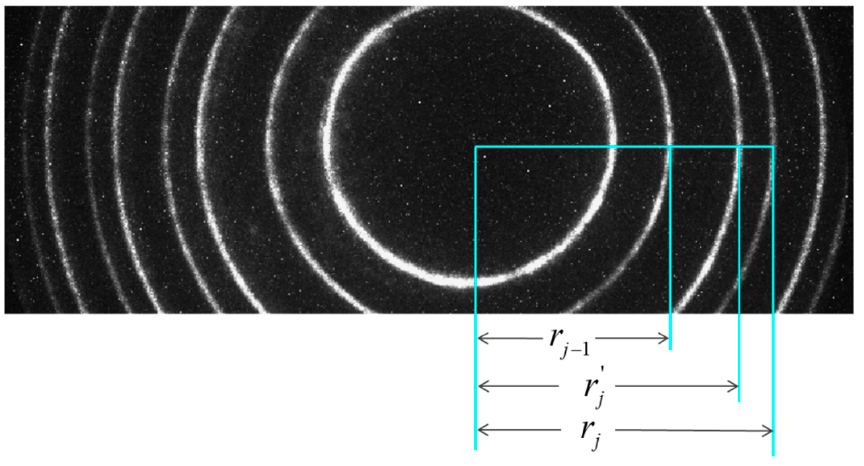
Figure 3. Measured scattering spectrum in seawater.